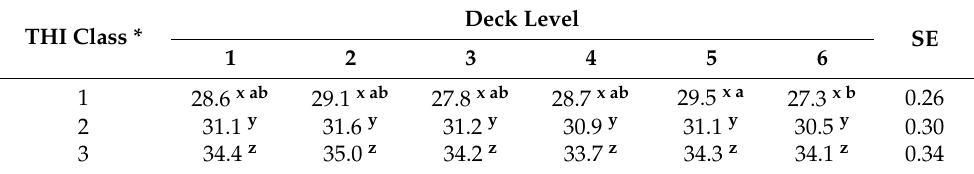
Table 3. Effect of the interaction between the class of the Temperature Humidity Index (THI) and deck level on the maximum surface temperature ( ◦ C) recorded at unloading by a thermal camera on the dorsal region of Italian heavy pigs transported approximately for 30 min under commercial conditions (least squares